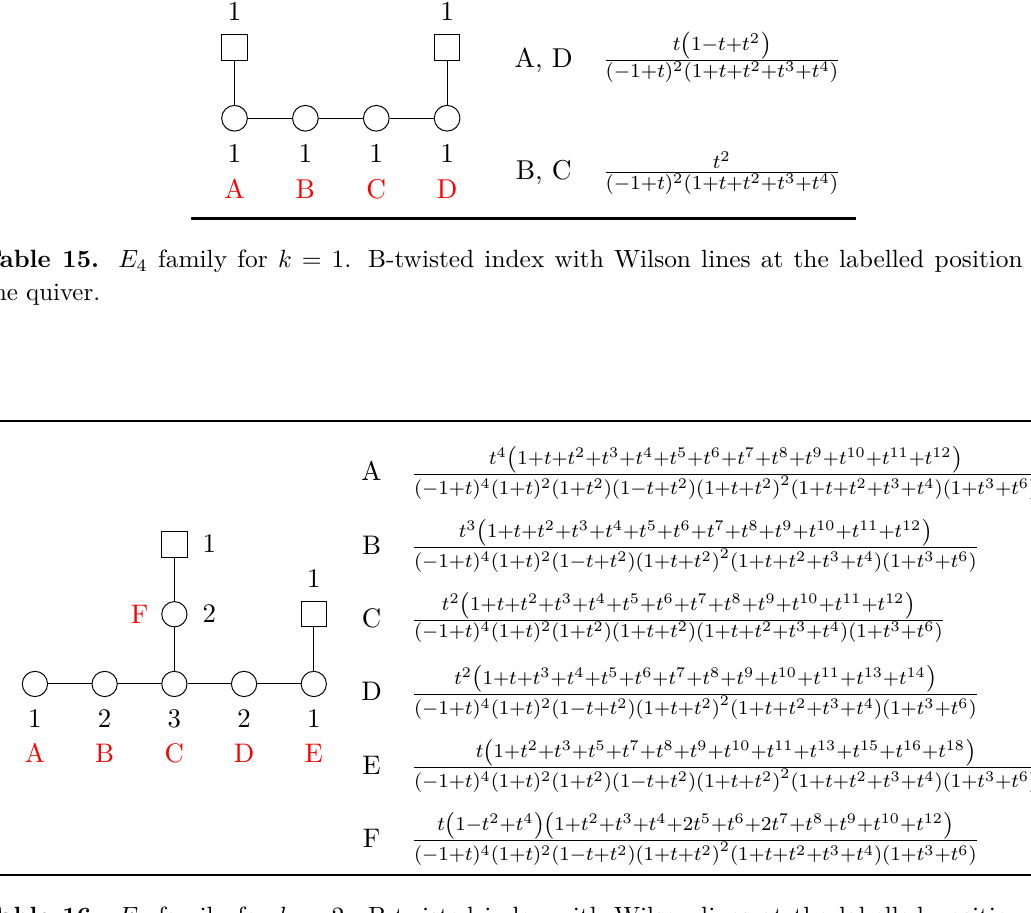
Table 16. E 4 family for k = 2 . B-twisted index with Wilson lines at the labelled position in the quiver.